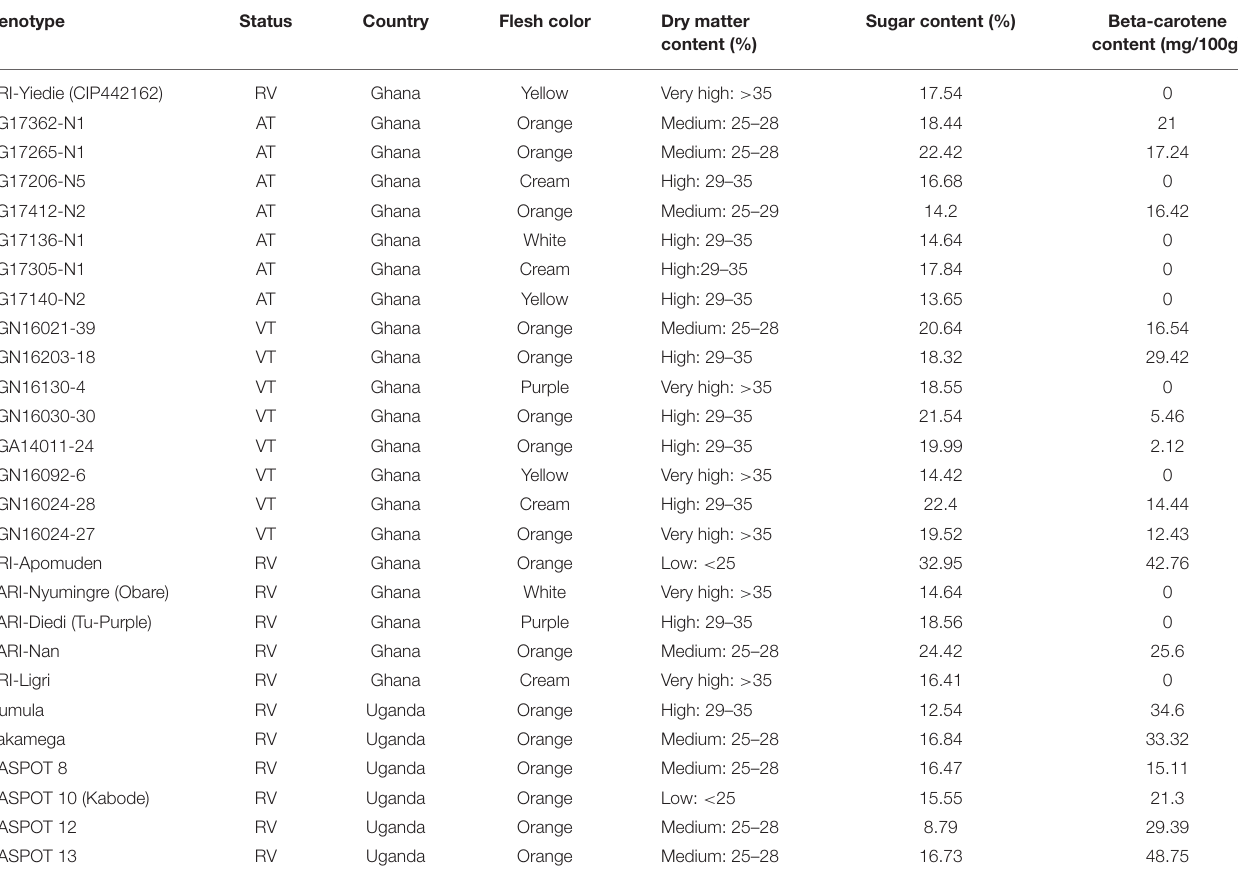
TABLE 1 | Characteristics of the sweetpotato genotypes utilized in this study. Genotype